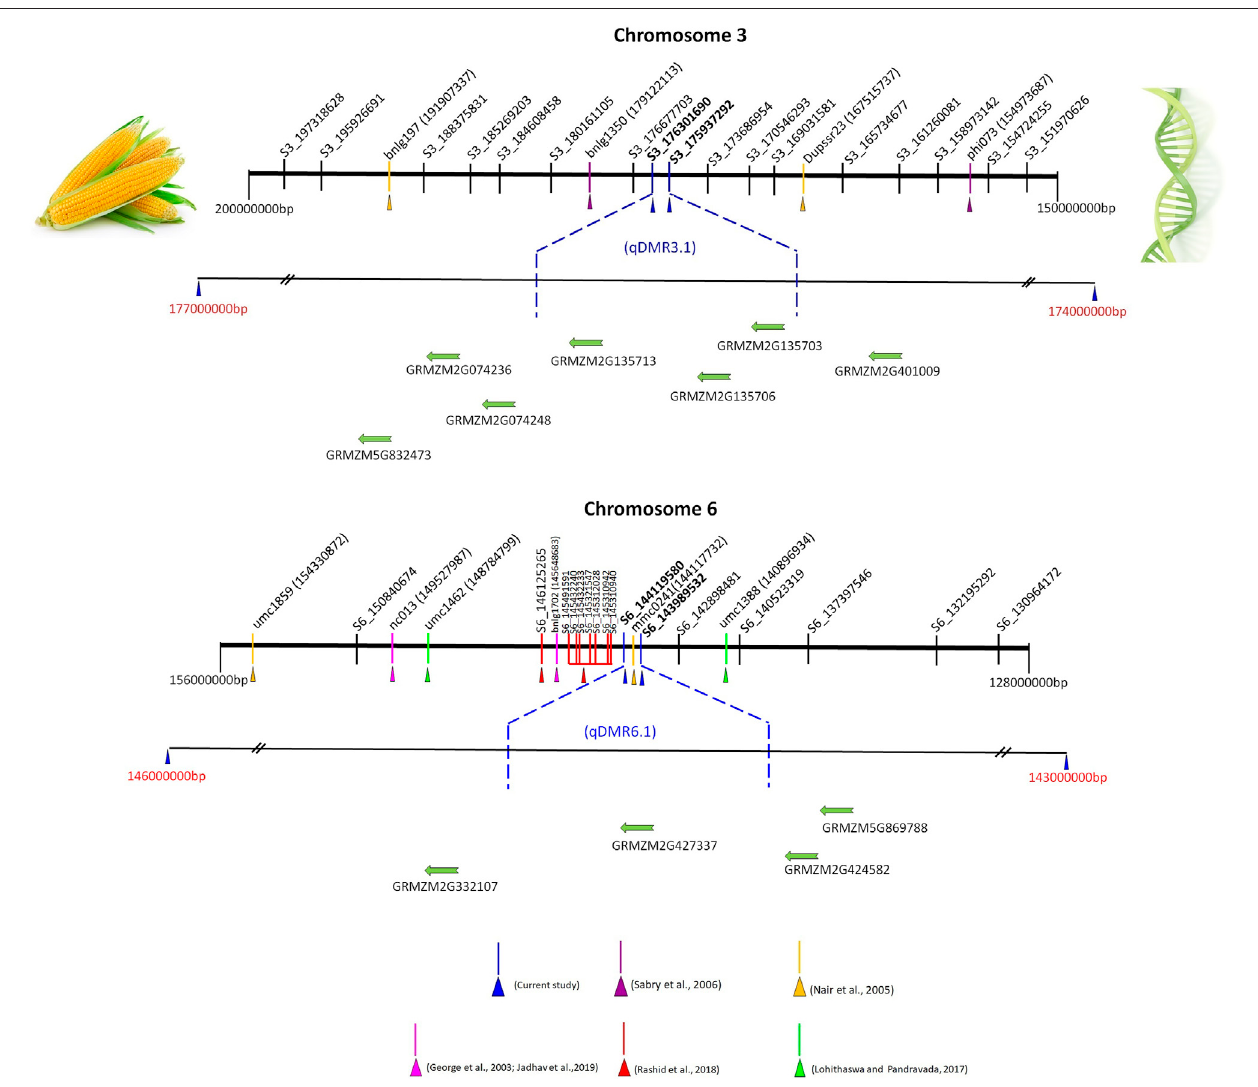
FIGURE4| IntegrativeviewsofqDMR3.1andqDMR6.1genomicregion(s)withalreadyreportedSDMresistanceQTLlocatedonchromosome3and6.Note:The numbers near to the SSR markers (phi073, Dupssr23, bnlg1350, and bnlg197 at chromosome 3 and nc013, bnlg1702, mmc0241, umc 1859, umc1388, and umc1462 at chromosome 6) in bracket are physical positions (bp) of markers in maize genome, while SNP markers ID denote the chromosome number and physical position. The physical position and gene details accessed on maize GDB (https://www.maizegdb.org/) (Veri fi ed 26th January 2022). SDM resistance QTL and linked markers [phi073, Dupssr23, bnlg1350, and bnlg197] on chromosome 3 (Nair et al., 2005; Sabry et al., 2006). SDM resistance QTL and linked markers [nc013, bnlg1702, mmc0241, umc 1859, umc1388, umc1462, S6_145310940, S6_145310942, S6_145312028, S6_145321547, S6_145432233, S6_145432240, S6_ 145491591, and S6_146125265] on chromosome 6 (George et al., 2003; Nair et al., 2005; Nagabhushan et al., 2017; Rashid et al., 2018; Jadhav et al., 2019). The putative candidate genes for qDMR3.1 and qDMR6.1 genomic region (s) only presented in this fi gure, the complete gene details around the QTL region summarized in Supplementary Tables S1 – 3 . The physical distance between markers or genes is